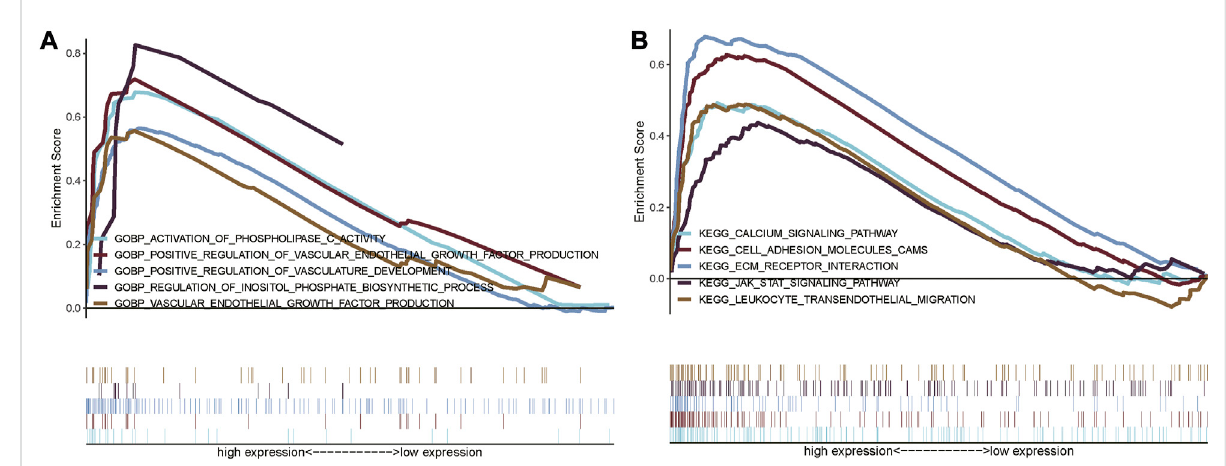
FIGURE 8 Gene set enrichment analysis showing the GO and KEGG enrichment between the high-risk and low-risk group. (A) GSEA for GO enrichment analysis; (B) GSEA for KEGG enrichment